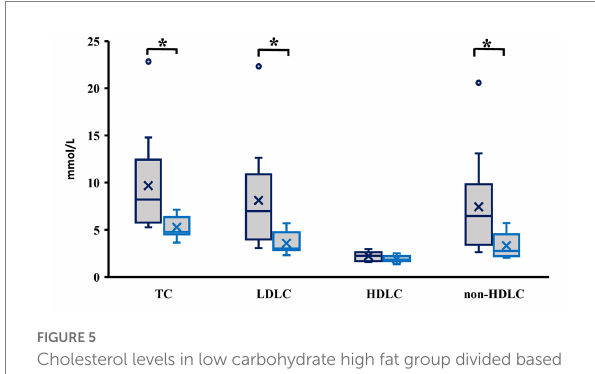
FIGURE 5 Cholesterol levels in low carbohydrate high fat group divided based on ketogenic ratio (KR). Dark blue—KR > 1.5; light blue—KR < 1.5. * p < 0.05; TC, Total Cholesterol; LDLC, Low-density lipoprotein cholesterol; HDLC, High-density lipoprotein cholesterol; non- HDLC = TC –